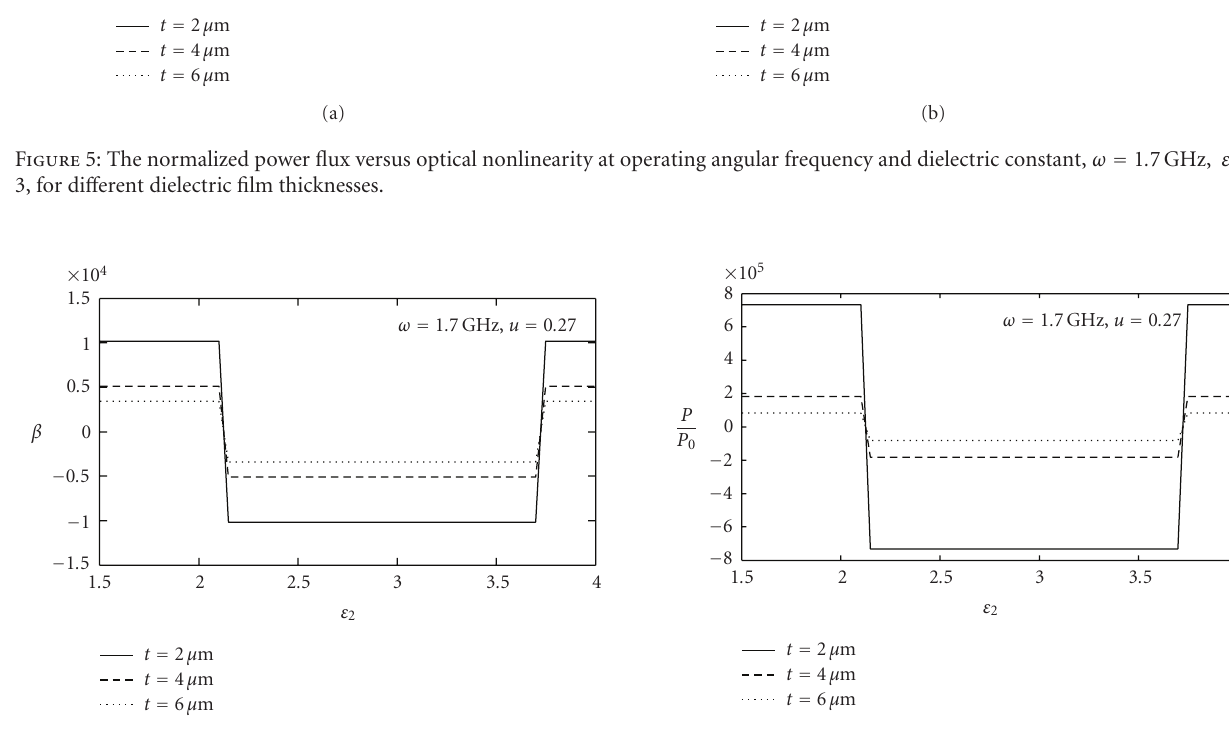
Figure 6: The e ff ective refractive index versus dielectric constant at operating angular frequency and optical nonlinearity, ω = 1 . 7GHz, u = 0 . 27, for di ff erent dielectric film thicknesses.